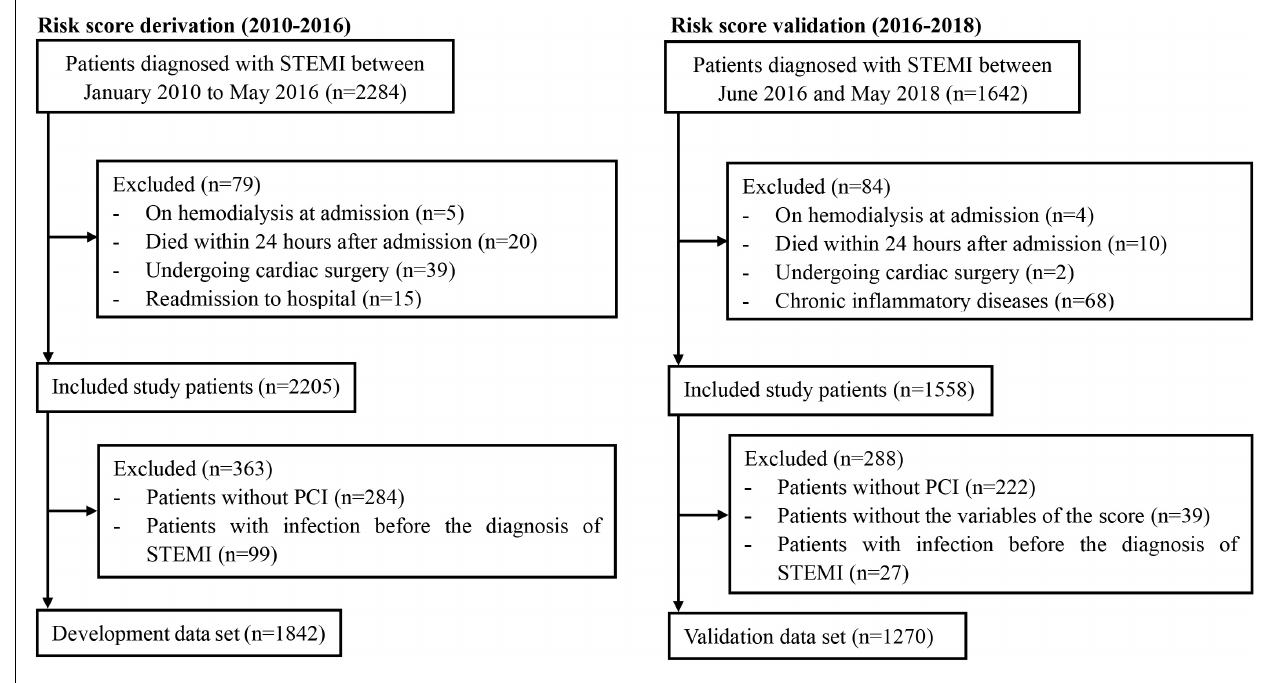
FIGURE 1 | Flow diagram of the included